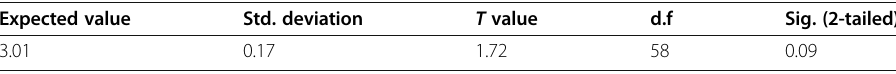
Table 6 Frequency distribution of researches by homogeneity Expected value